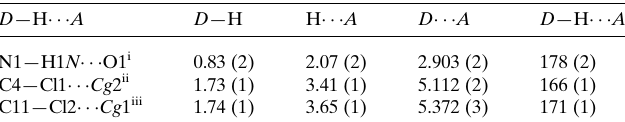
Table 2 Hydrogen-bond geometry (A˚ , (cid:3) ) for (I).